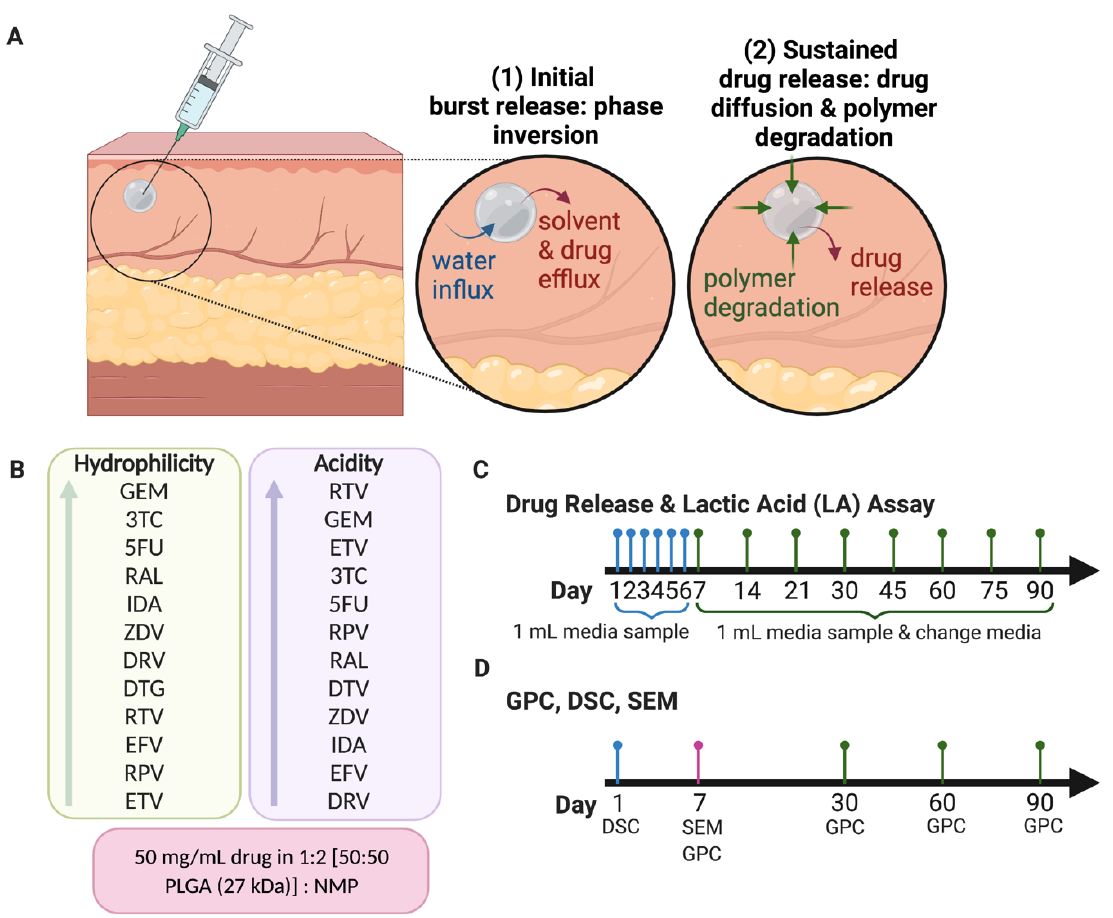
Figure 1. Study outline to determine the effects of drug physicochemical properties on ISFI degradation and drug release kinetics in vitro. Figure created with BioRender.com, accessed on 6 May